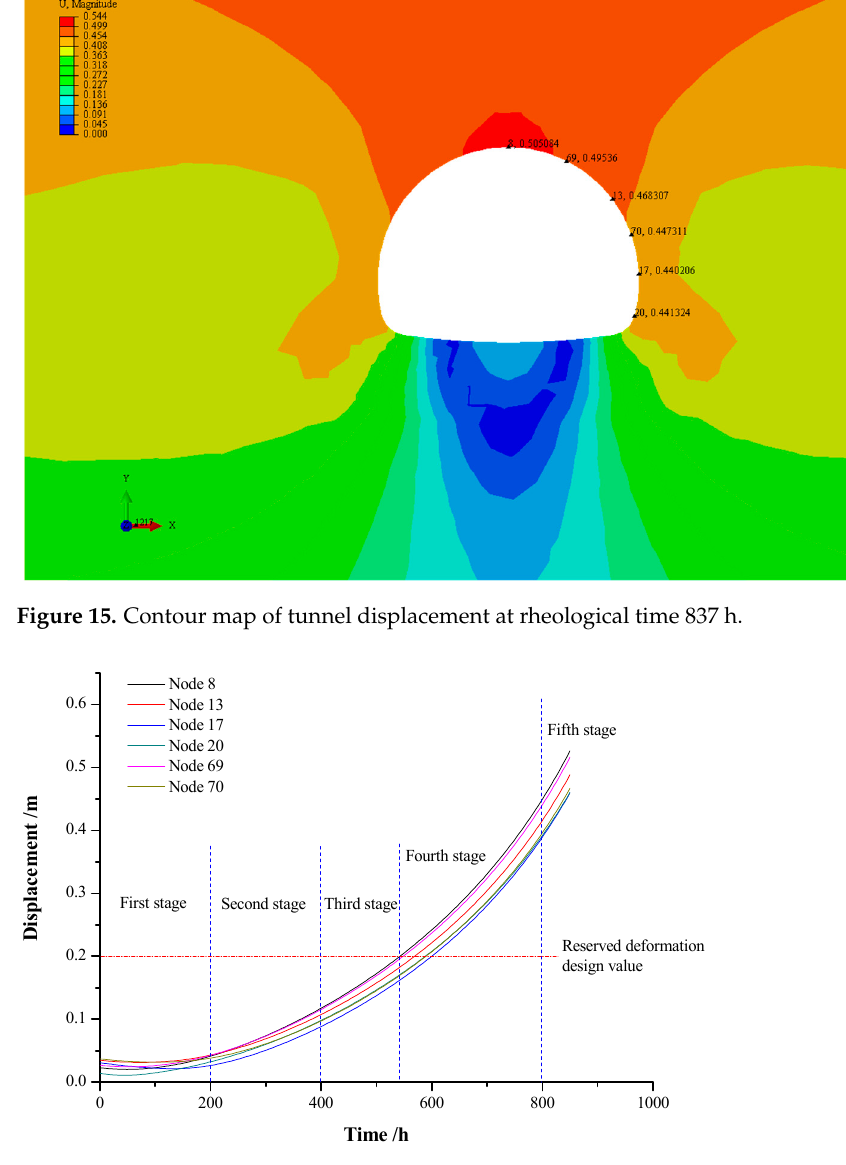
Figure 14. Contour map of tunnel displacement at rheological time 721 h.